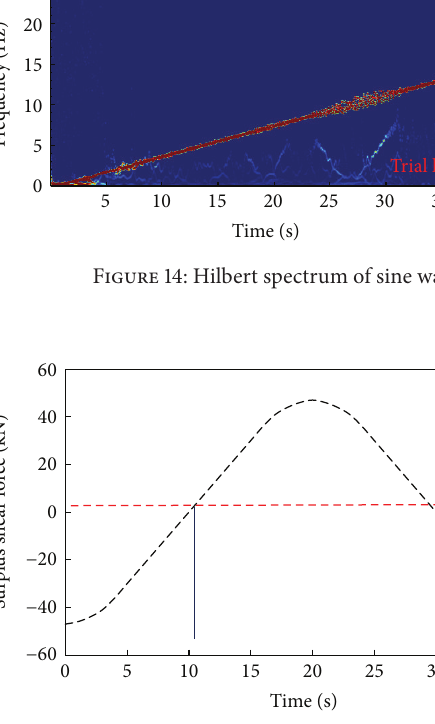
Figure 15: Result of TFA analysis